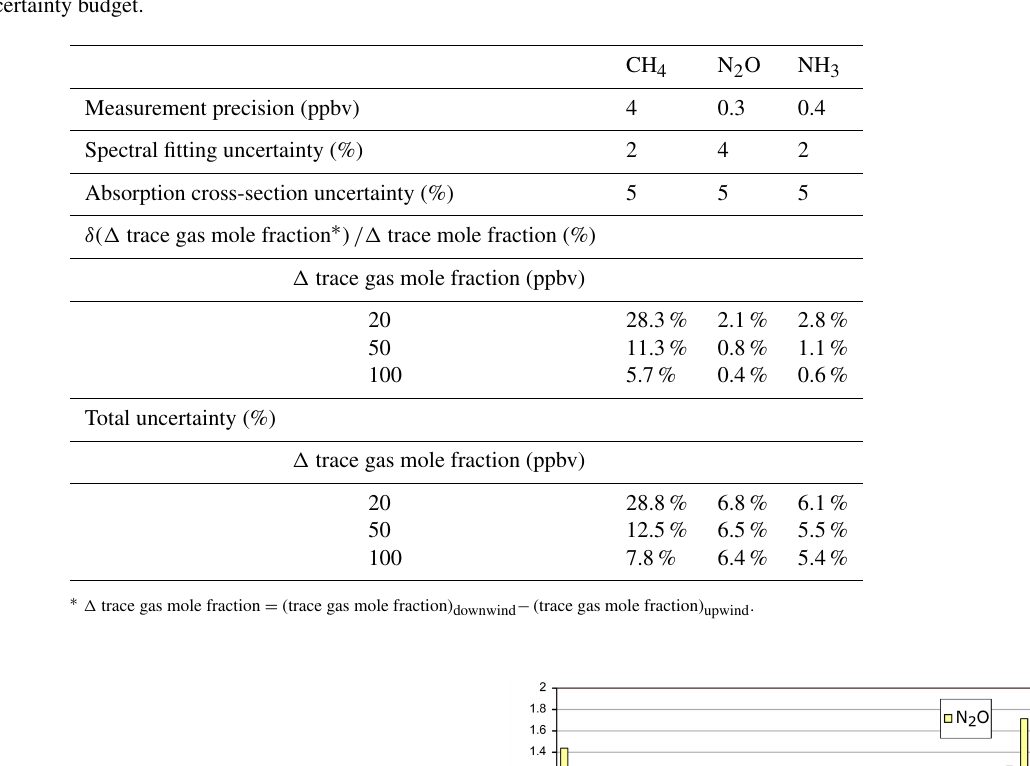
Table 9. Total uncertainty budget.